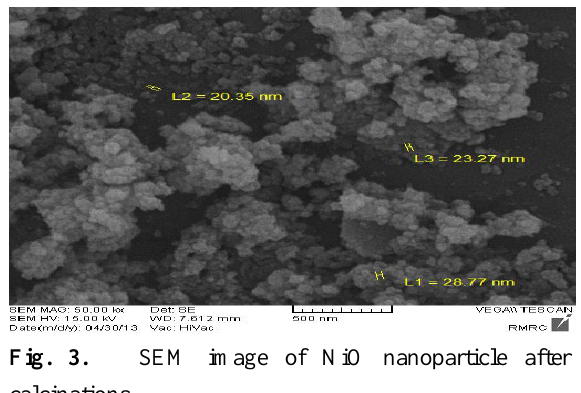
Fig.3 shows the scanning electron microscopy (SEM) image of NiO nanoparticles with magnification of 5000 after calcination.